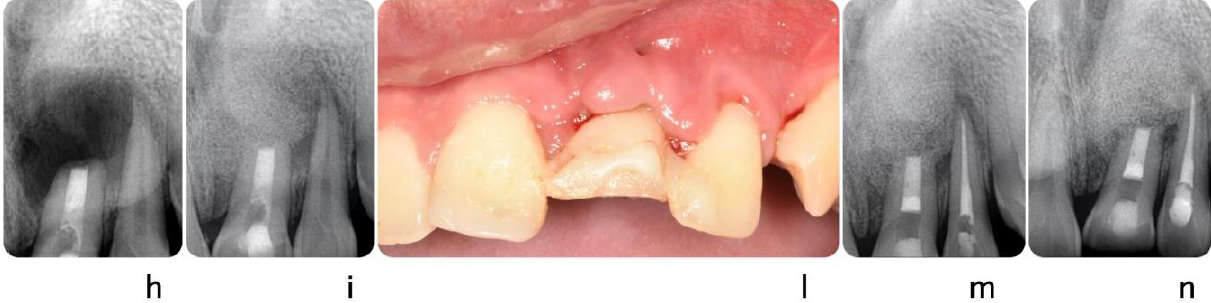
Figure 5. Clinical scenario of a 17 years-old adolescent hit by a baseball ball in the anterior maxillary region. The boy presented to the Periodontal Department at Tufts University, Boston USA with crown fracture of left central incisor (#9) ( a , b ). Peri-apical radiograph show apical radiolucency, sign of necrosis. After the diagnosis, CaOH 2 was applied. The root canal definitive treatment was completed but after 2 months the patient still presented with a fistula, that was tracked via a gutta-percha point. A CBCT scan was performed in order to diagnose the extent of the peri-apical lesion ( c in sequence). The extent of the lesion did not suggest an endodontic therapy revision. Exploratory surgery was performed in order to rule out tooth fracture ( d ). The apex was resected in order to access the palatal aspect of the tooth. A PA radiograph was taken in order to verify correct apex resection and endodontic retrograde seal ( e ). Due to active patient skeletal growth, a decision was made to enucleate the endodontic cyst and treat the cavity with bone grafting material, in order to preserve the site for future implant placement ( f , g ). PA radiograph comparison before and after grafting placement ( h , i ). The patient was followed up for 2 months, and a fistula was identified apical to #9 ( l ). Tooth #10 was diagnosed as necrotic. A root canal was performed ( m ) and the apical radiolucency and fistula were resolved at 1 month follow up ( n ).